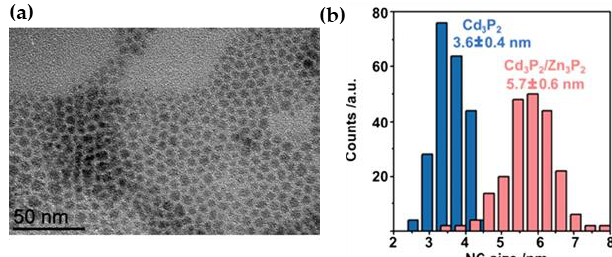
Figure 1. ( a ) TEM image of Cd 3 P 2 /Zn 3 P 2 core-shell NCs. ( b ) Histograms of measured NC sizes for Cd 3 P 2 cores and Cd 3 P 2 /Zn 3 P 2 core-shell NCs.